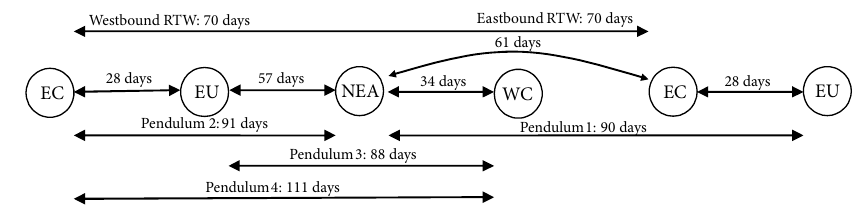
Figure 11. Average voyage time of different route patterns in 2001 (EC – East Cost North America;